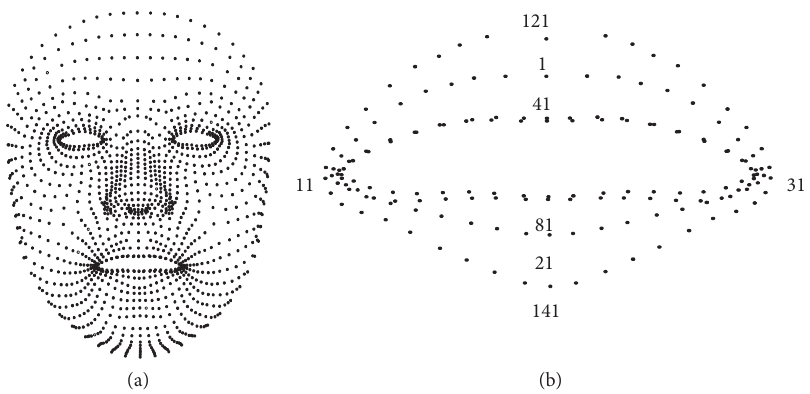
Figure 2: (a) Predefined 1347 planar facial points. (b) Reindexed 160 points of lip area.